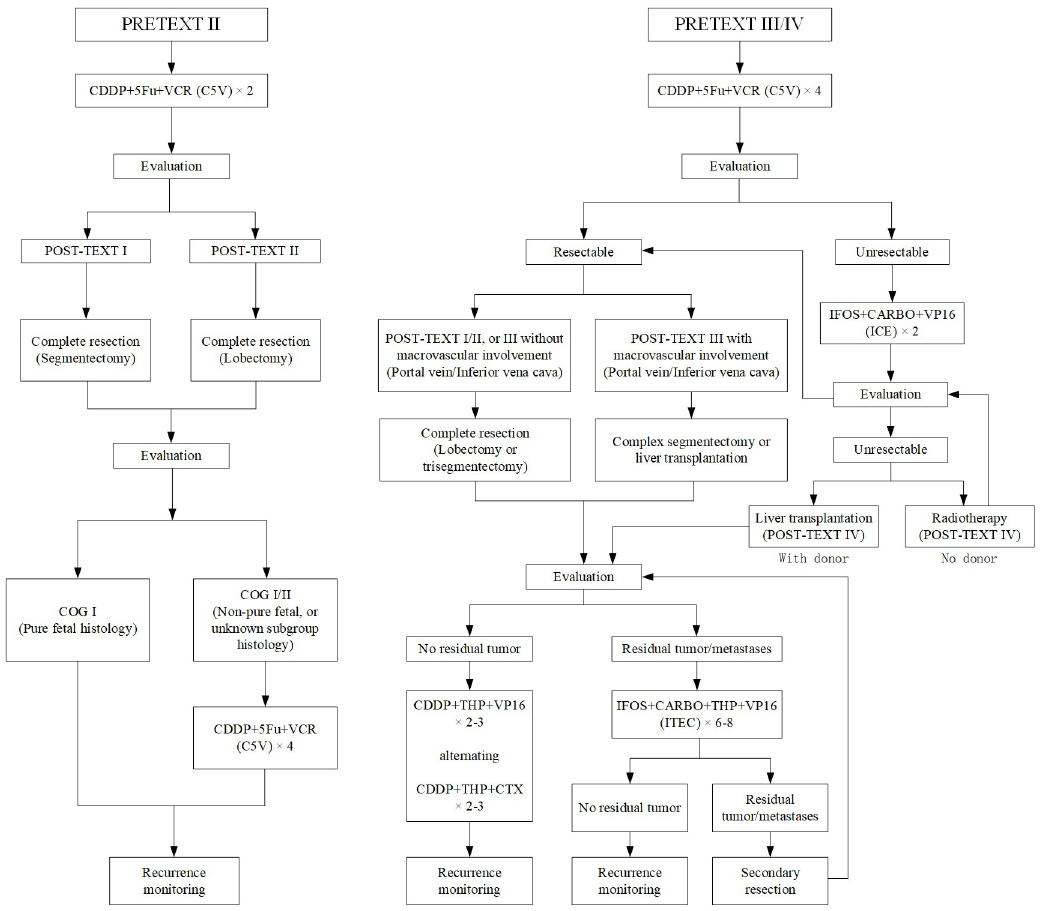
Fig 1. Therapeutic protocol. The comprehensive therapeutic protocol for